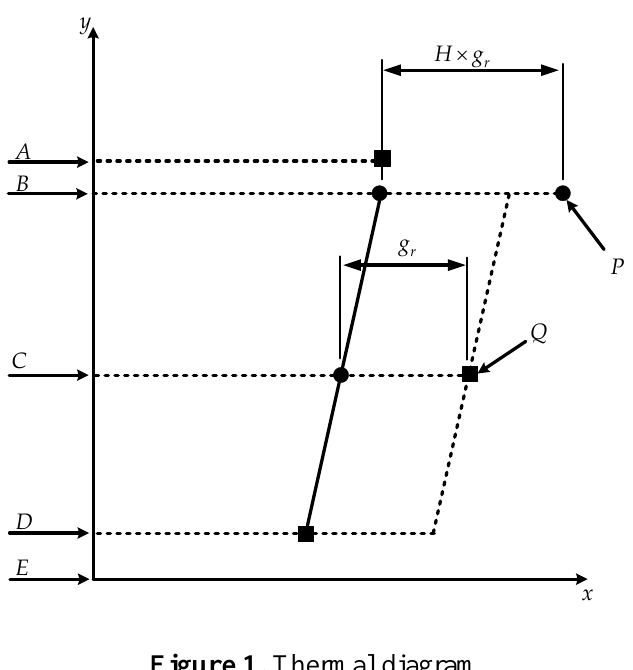
Figure 1. Thermal